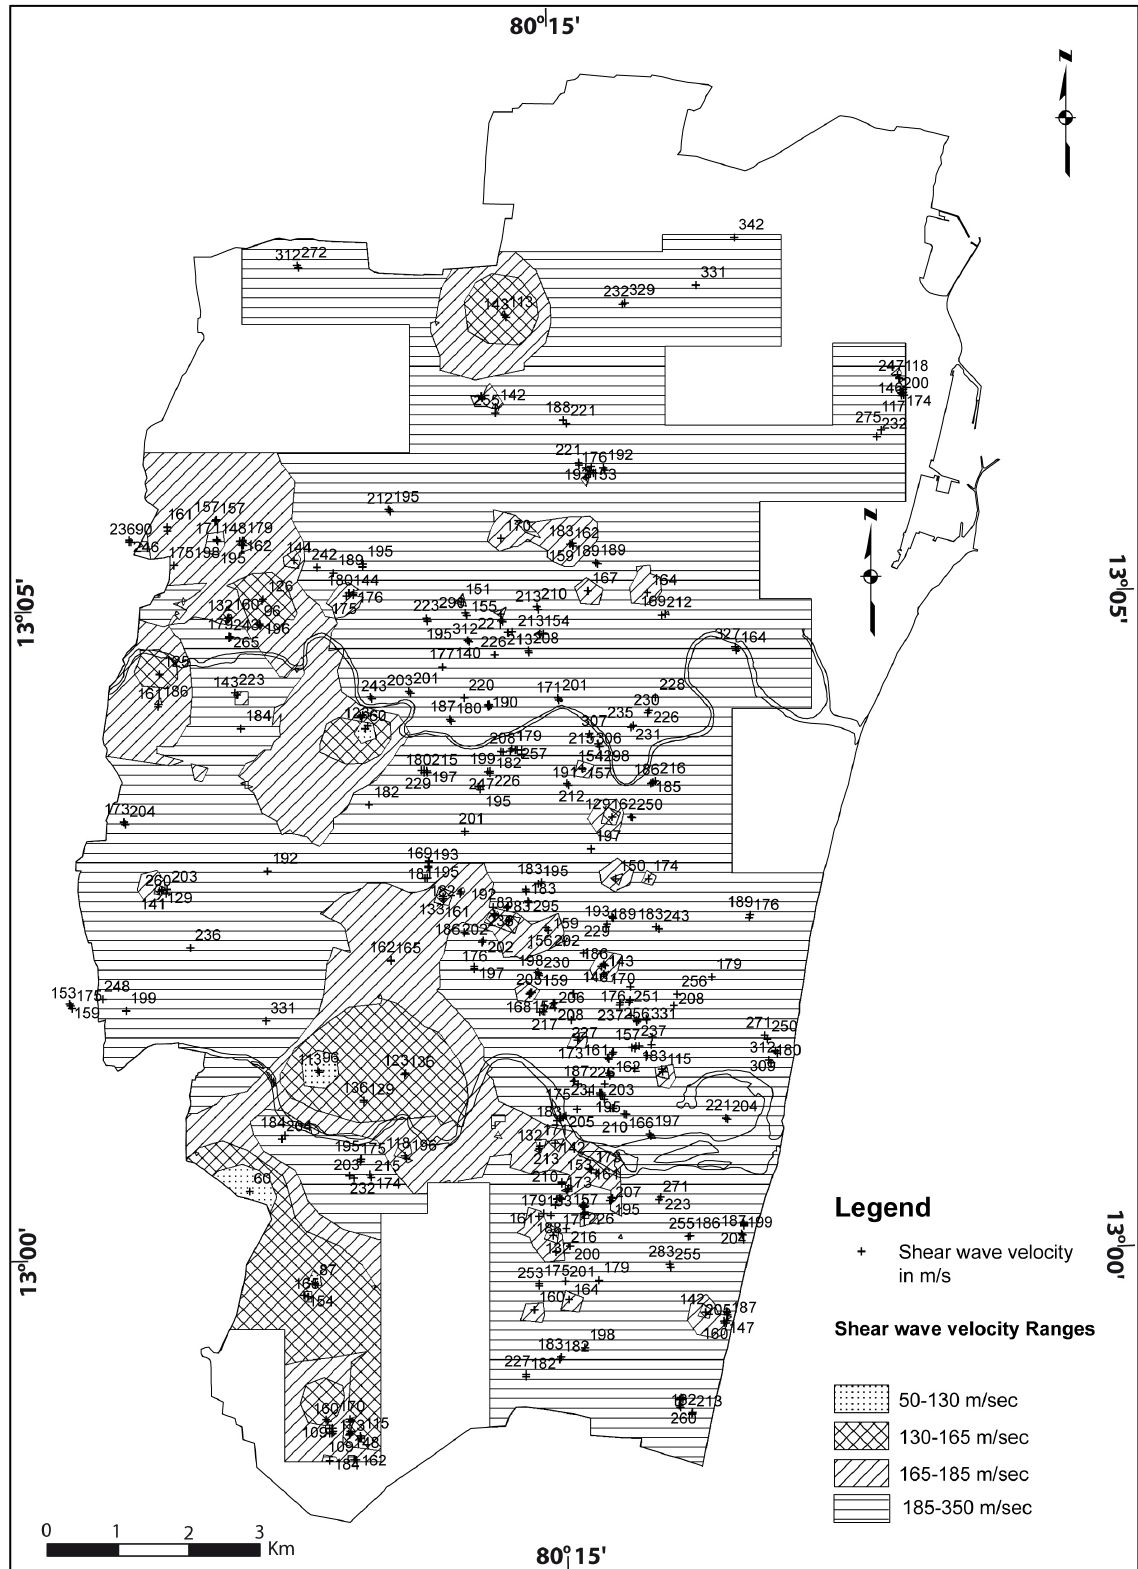
Fig. 4. Estimated shear wave velocity at 3m